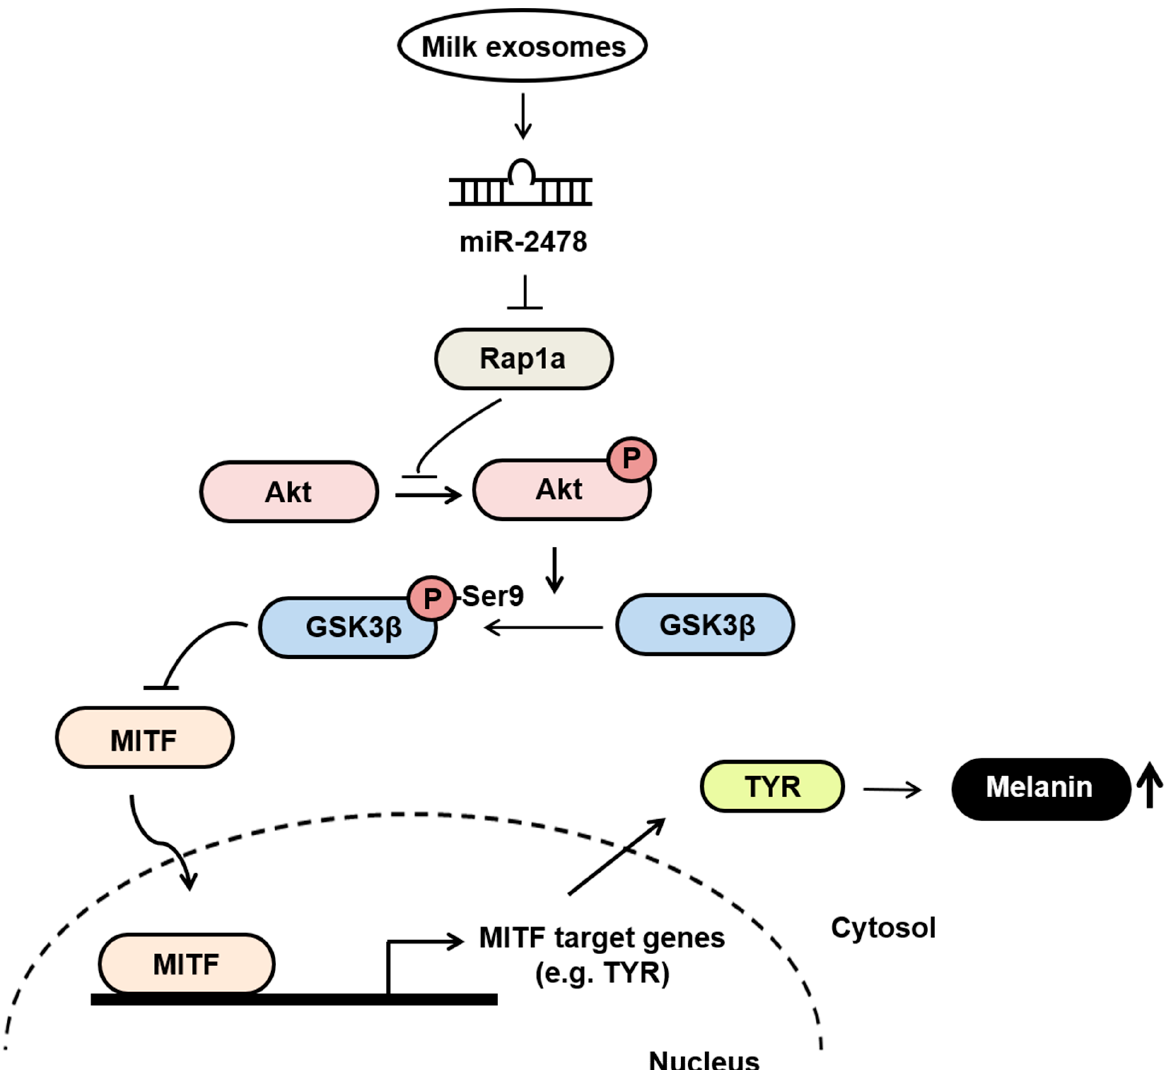
Figure 10. The proposed model explaining how milk exosomes inhibit melanin production in melanoma cells. In the absence of milk exosomes, Rap1a maintains the active form of GSK3 β by inhibiting Akt phosphorylation. The dephosphorylation of GSK3 β upregulates the melanogenesis-related protein MITF, which promotes melanin production by driving the expression of tyrosinase. However, in the presence of milk exosomes, miR-2478-carrying milk exosomes inhibit Rap1a expression in melanoma cells, and thus promote the activation of its downstream mediator Akt (via phosphorylation), resulting in GSK3 β phosphorylation at Ser9; this change inactivates GSK3 β and represses the expression of melanogenesis-related genes such as MITF and TYR, thereby inhibiting melanin production.